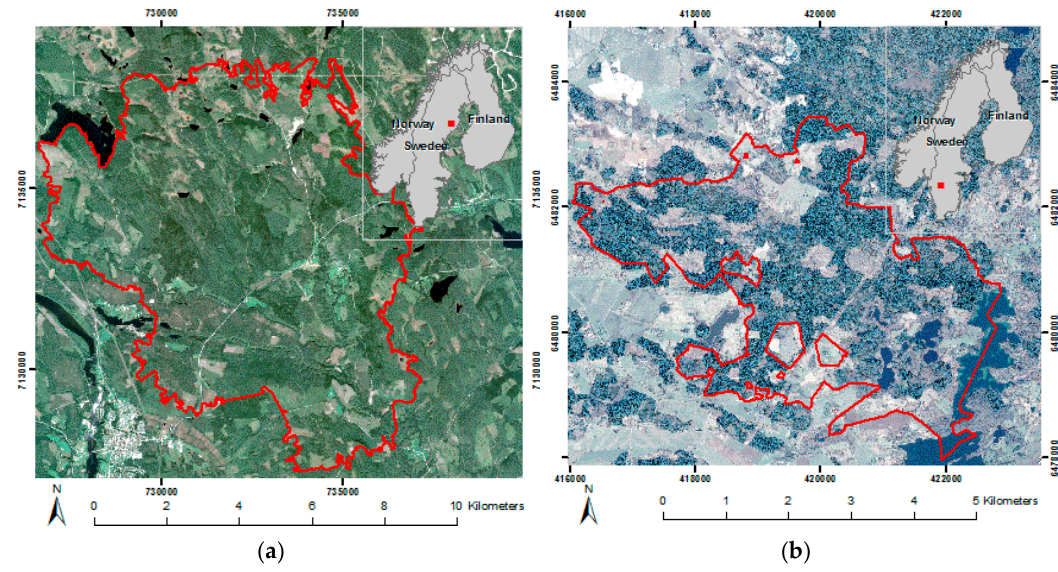
Figure 1. Ortho-rectified Pléiades images of the two test sites superimposed in red. Krycklan ( a ) and Remningstorp ( b ), located in northern (64 ◦ N) and southern (58 ◦ N) Sweden, respectively, projected in the UTM 33N coordinate system on the WGS84 reference ellipsoid.